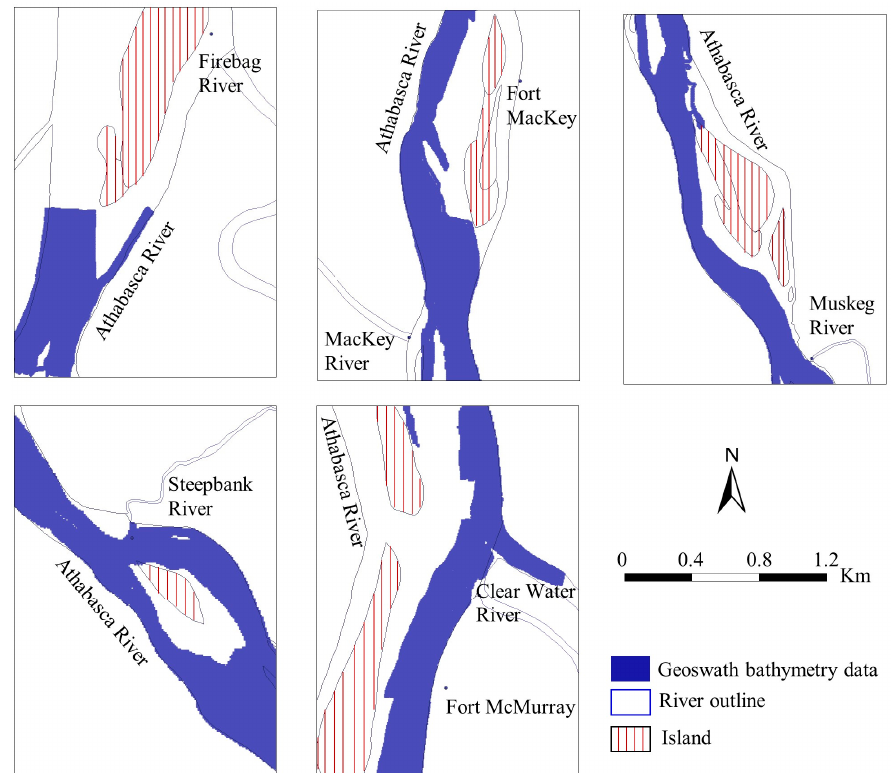
Figure 3. Geoswath bathymetry data gaps at selected locations.